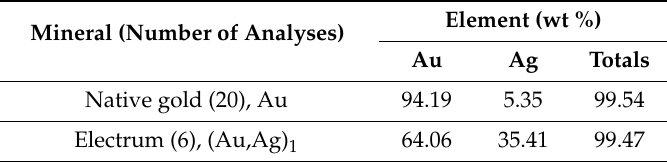
Table 8. Chemical composition of Au minerals of altered sulfide breccias with aragonite cement.